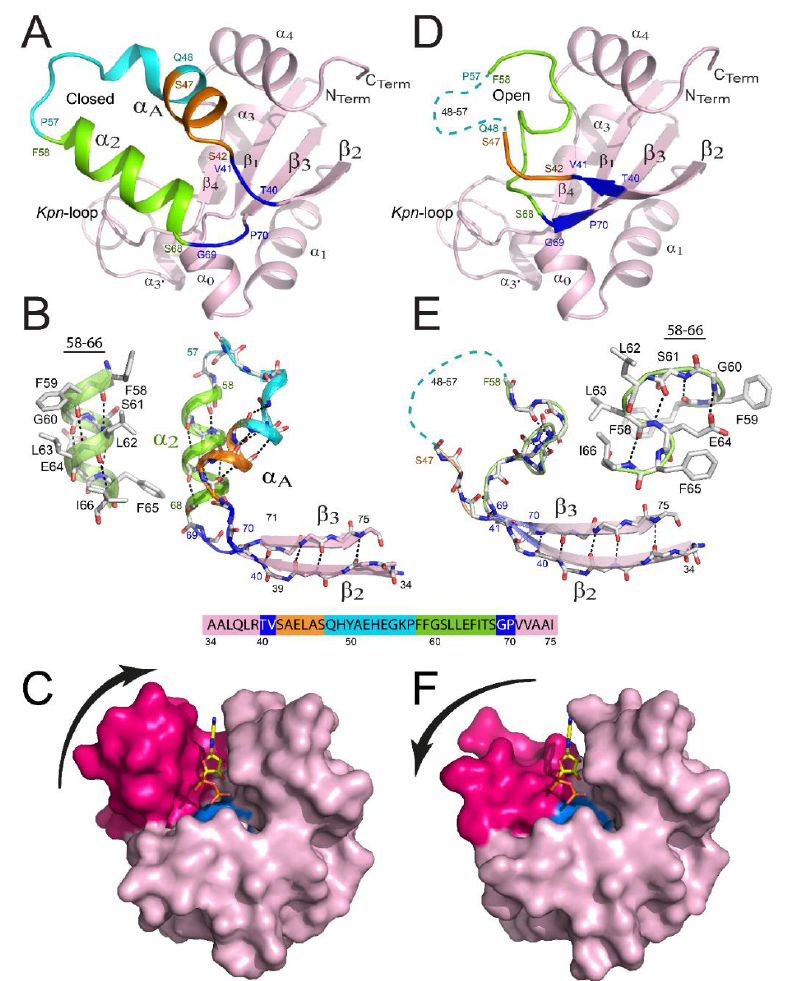
Figure 3. Remodeling of the binding site of NDPK from M. tuberculosis. View of a monomer presenting a closed structure ( A ) versus the remodeled one ( D ). The β 2 α A α 2 β 3 region is remodeled in the latter monomer, and details are provided in panels ( B , E ), respectively. Residues 40–41, 42–47, 48–57, 58–68, and 69–70 are colored blue, orange, cyan, green, and blue, respectively. The region covering residues 48–57 is not visible in the X-ray structure for monomers and is shown as a cyan dashed line in panels D and E. The α 2 helix ( B ) and the successive β -turn structures ( E ) are shown as cartoons and ball-and-stick structures. The surface views of the monomer are displayed in the closed ( C ) and open ( F ) conformations. α A and α 2 helices are colored magenta and the catalytic His117 is colored cyan. ADP is bound in the active site by homology with NDPK-A. (Figure adapted with permission from [41]).